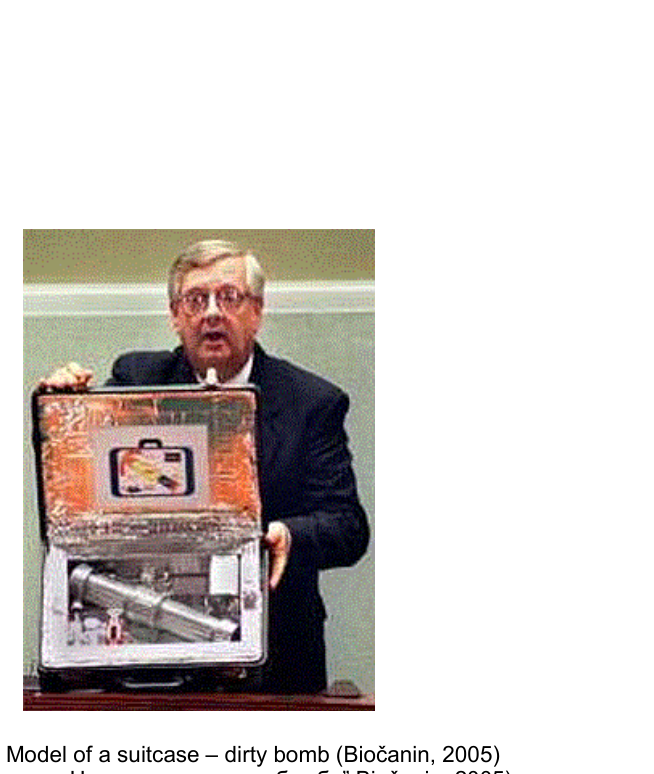
Figure 4 – Model of a suitcase – dirty bomb (Bio č anin, 2005) Рис . 4 – Модель „ Чемодан – грязная бомба ” Bio č anin,